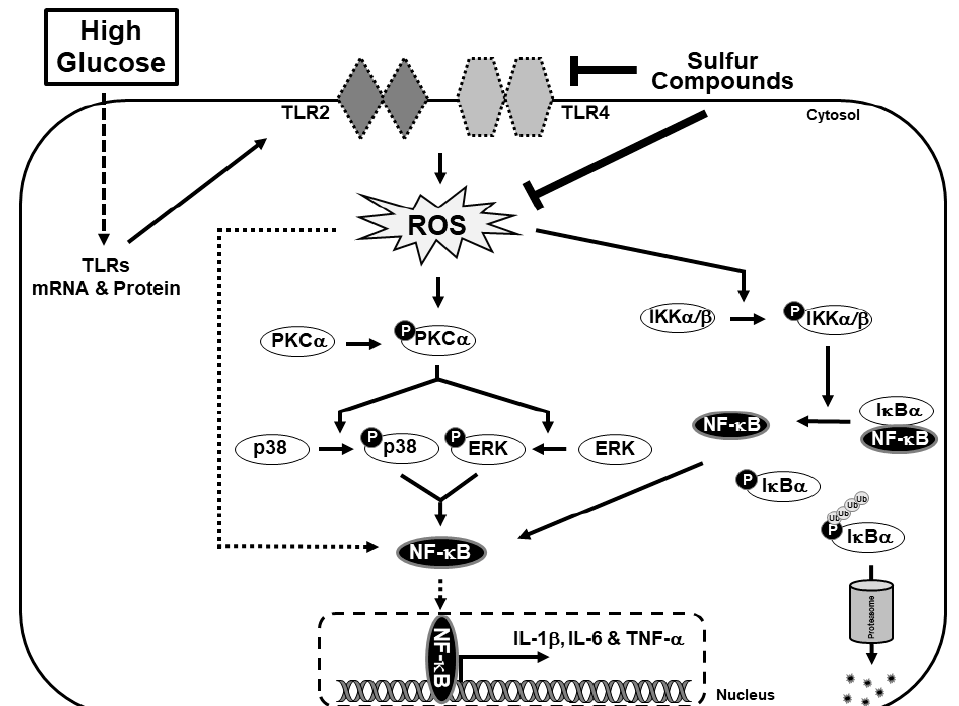
Figure 6. Molecular regulatory mechanism of high glucose-induced inflammatory responses by TLRs/NF- κ B through ROS-mediated canonical and PKC-mediated pathways. The anti-inflammatory activities of NTS and MSM are mediated by inhibiting these pathways and the binding of NF- κ B to proinflammatory cytokines.